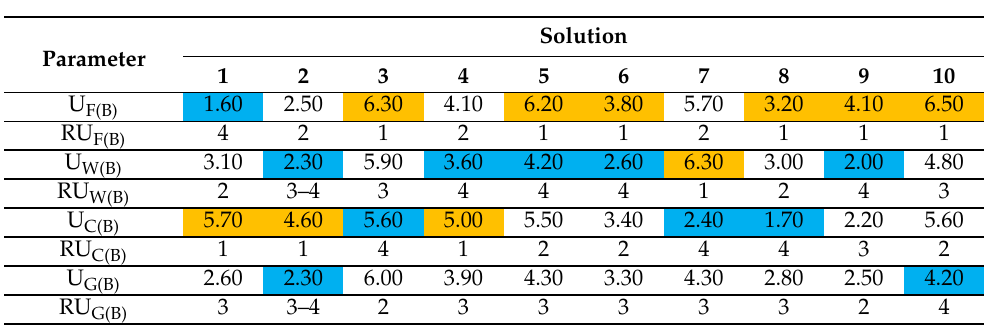
Table 7. Survey results and ranking of mean uniformity levels of computer image of corridor for each solution, in group B.